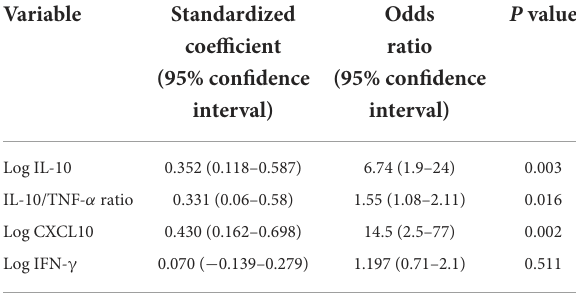
TABLE 3 Univariate regression analysis of plasma cytokines and chemokines with Stress Hyperglycemia Ratio in patients hospitalized with COVID-19 infection.